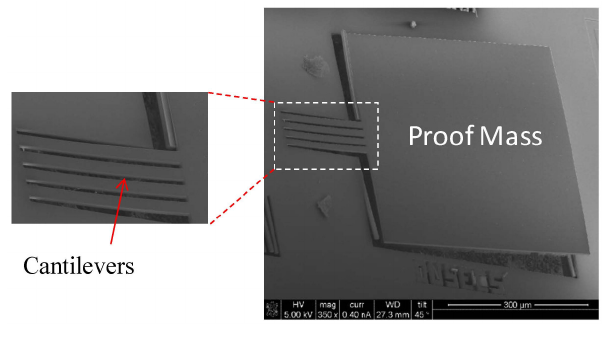
Figure 10. SEM image of the fabricated CMOS-MEMS accelerometer with the inset showing the composite beams where piezoresistors are located.